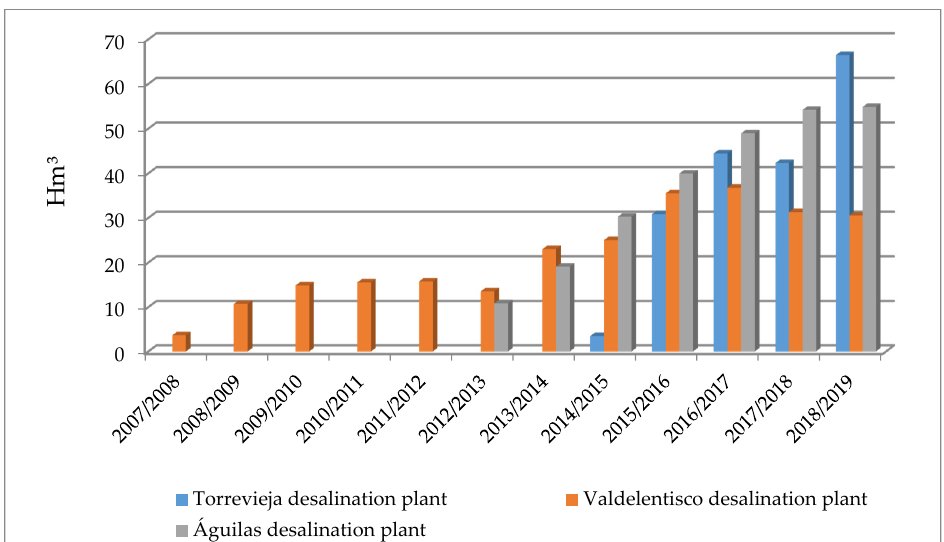
Figure 2. Desalinated water annual production of the plants owned by ACUAMED in the SRB (2007–2019). Source: own elaboration from ACUAMED data.